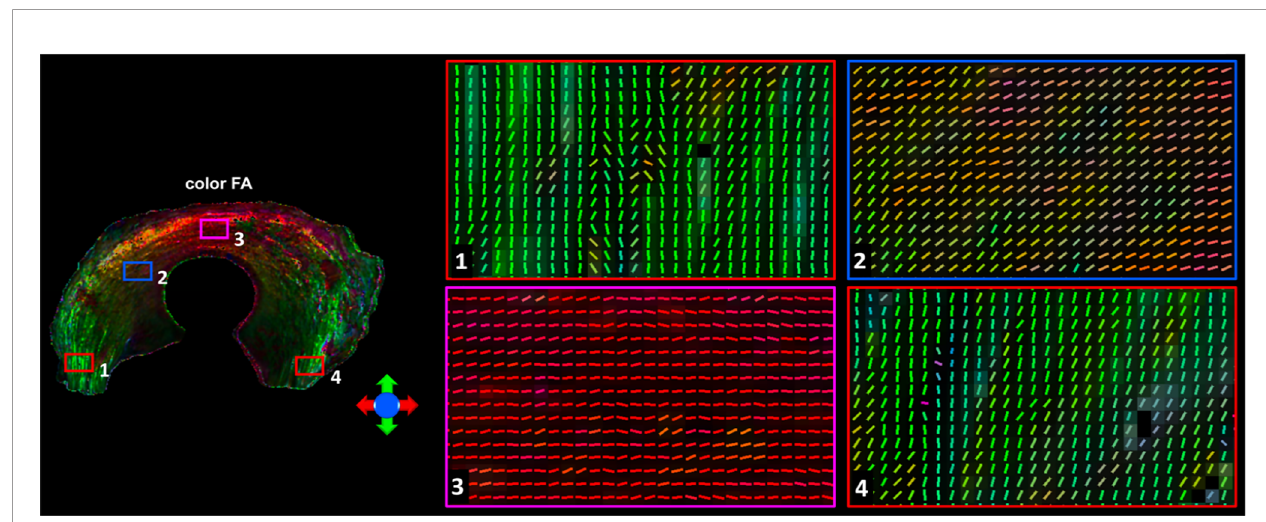
FIGURE 3 | The color-FA and the fi ber orientation images of meniscus at different regions. Red for horizontal fi ber, green for vertical, blue for inside-out. The collagen fi ber orientations were shown at 4 different